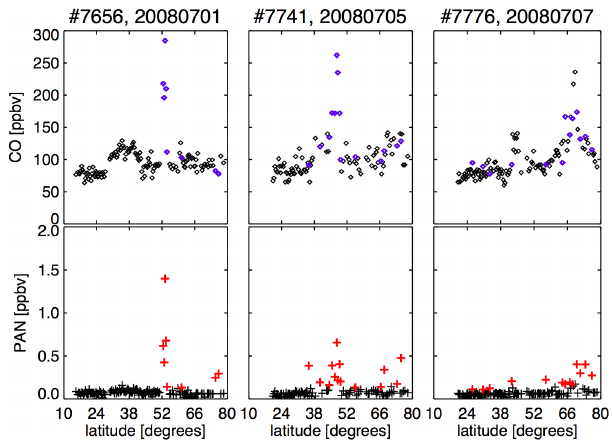
Figure 9. Examples of elevated CO and PAN in boreal burning plumes (previously identified by Alvarado et al. (2010)) seen in TES special observations made during the July 2008 phase of the ARCTAS campaign. Colored points show the cases where the DOFS was greater than 0.6 for the PAN retrieval.